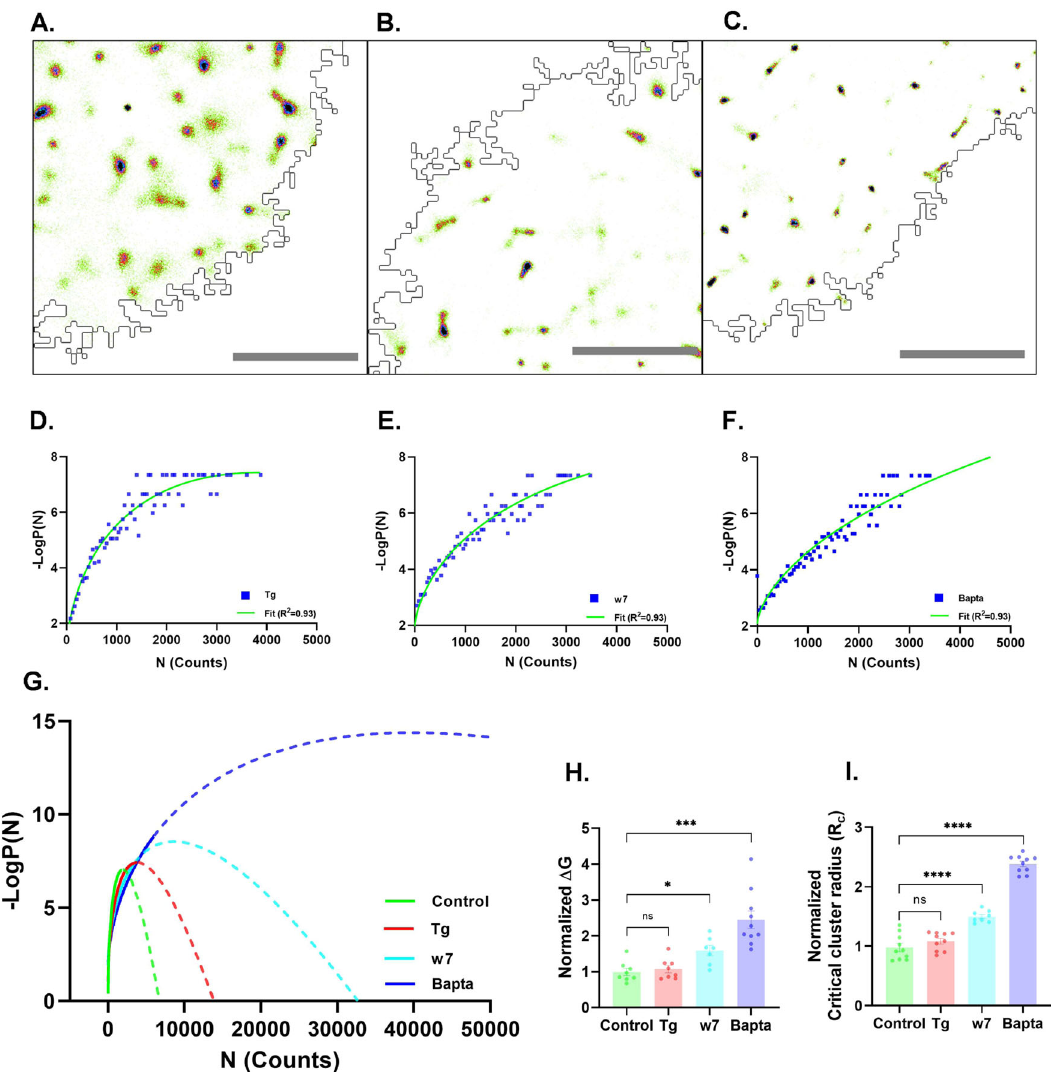
Fig. 2 Intracellular Ca 2 + levels can regulate the super-saturation of SAP97/hDLG nanoclusters. Reconstructed super resolved images (500 × 500 pixels) of SAP97/hDLG in Neuro-2a cells treated with A Thapsigargin (Tg), B w7, C Bapta, and D – F their – Log(( n )) vs. n curve, from each condition. G The functional fi t of – Log( P ( n )) from different pharmacological treatments. H The normalized free energy barrier for each condition, calculated from the functional fi t, is plotted and compared with control. I The plot represents the normalized critical cluster radius (nm) during different treatments, compared to control data. The data is from 1000 – 1500 clusters ( N = 10 cells (Control, Tg and Bapta), 8 cells (w7)) in each condition cumulated from three experiments. Statistical test for Δ G c and R c was performed by one-way ANOVA. Log refers to the natural logarithm to base “ e ” . Data are presented as mean values ± SEM. * p < 0.05, **** p < 0.0001 (Supplementary Table 1). Scalebar = 4 µ m. Source data are provided as Source Data fi The scaling factor corresponding to the highest p -value was slopes of 1.67, 2.72, and 1.72, respectively (Fig. 3D – F). Then, we chosen as the actual scaling factor. The resultant values of actual veri fi ed whether these data indicated an up or down scaling of the scaling factors for Tg, w7, and Bapta incubations were 1.66, 3.10, morpho-functional properties of clusters 48 in these different and 3.76, respectively (Fig. 3G – I). Thus, the scaling factors conditions. The actual scaling factor of the average intensity of showed an upscaling of the average intensity of SAP97 in these nanodomains in the treated vs. control cells were estimated. For clusters. The cumulative frequency distribution (CFD) of the the purpose, the datapoints from each treated condition (Tg/w7/ average intensity of control, treated, and scaled-treated datasets Bapta) was divided by 100 values within the range of the arbitrary were plotted against the average intensity (Fig. 3J – L). When the scaling factor, keeping the arbitrary value as the median. The treated datasets were downscaled by the actual scaling factor, the resultant datasets were named as scaled-treated data. To deter- scaled-treated datasets replicated the control data. This scaling mine the actual scaling factor, the control and the scaled-treated was con fi rmed by the plot of the CFD curve of average intensity datasets were tested for signi fi cance using Kolmogorov – Smirnov (Fig. 3J – L). In parallel, we studied the effect of Ca 2 + perturbation test (K – S test) 48 . The actual scaling factor should give highest p - value, as the difference in the datasets would be non- signi fi cant. on the area of SAP97/hDLG clusters. The frequency distribution The method was repeated 100 times with each dataset. The results histograms were plotted for the treated and control conditions provided us with 100 p -values for each condition, and they were (Supplementary Fig. 2A – C). A total of 1000 cluster area data- plotted against their corresponding scaling factors (Fig. 3G – I). points were chosen randomly from each dataset and rank-